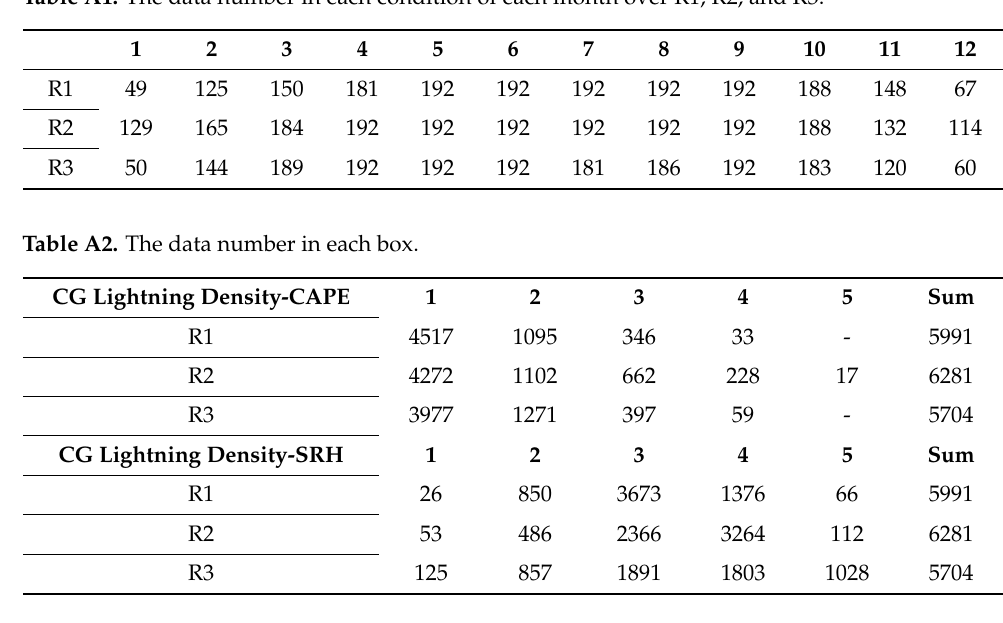
Figure A3. Same as in Figure A1 , but for R3. Table A1. The data number in each condition of each month over R1, R2, and R3.